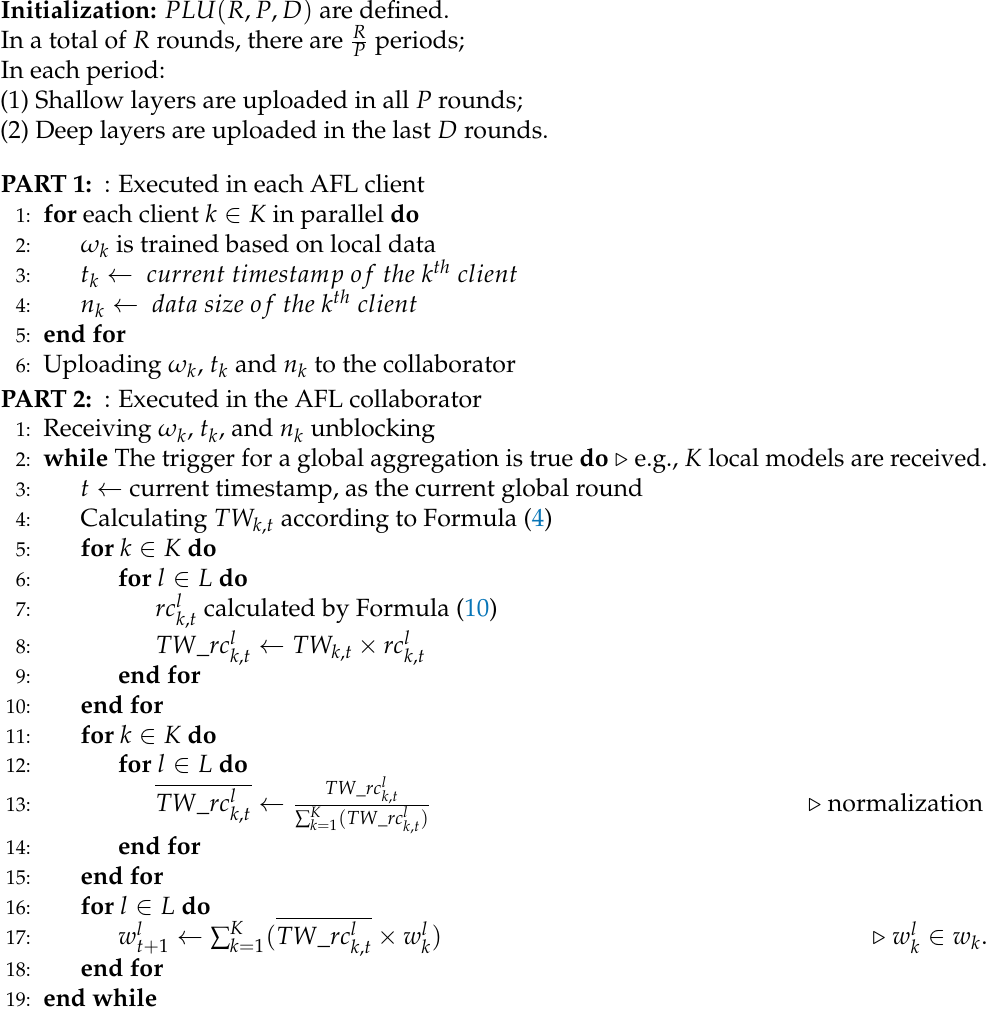
Algorithm 1 Fed2A: Integrated with PLU , TVW , and RCE